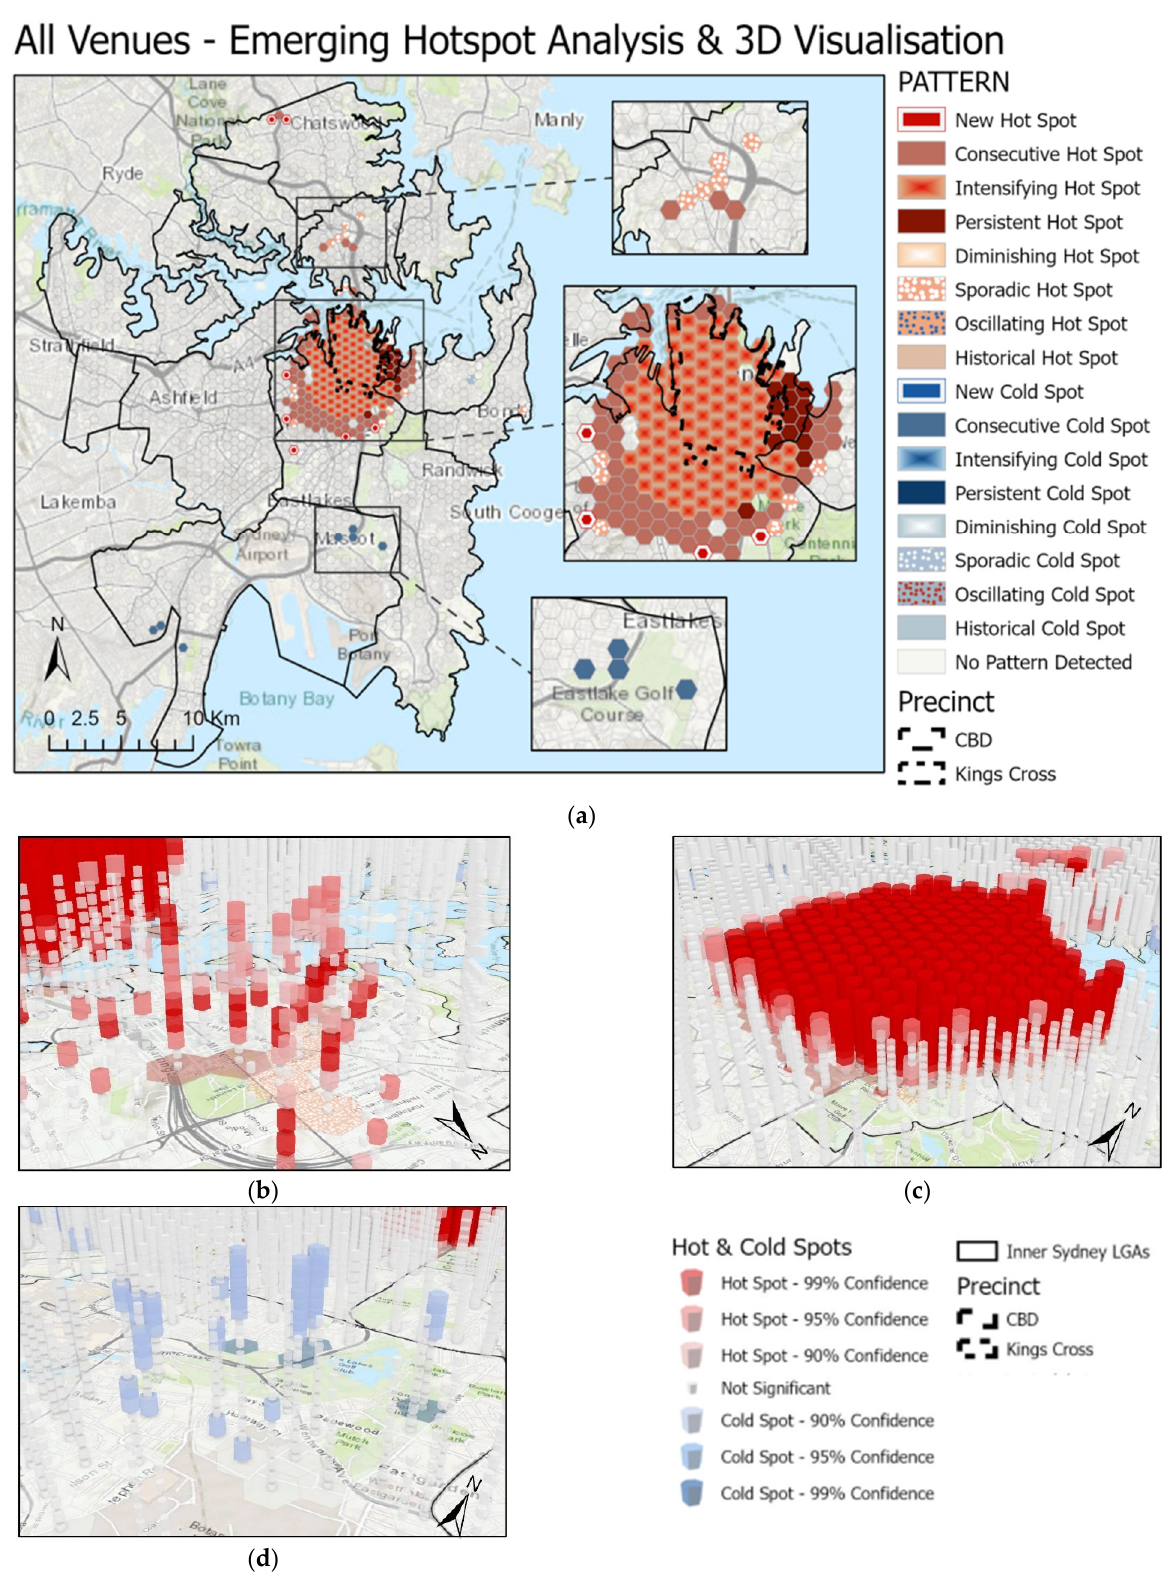
Figure 19. ( a ) All venues spatio ‐ temporal analysis 2012–2021; ( b ) All venues space ‐ time cube 3D visualisation northern section; ( c ) All venues space ‐ time cube 3D visualisation south ‐ western section (1); ( d ) All venues space ‐ time cube 3D visualisation south ‐ western section (2).